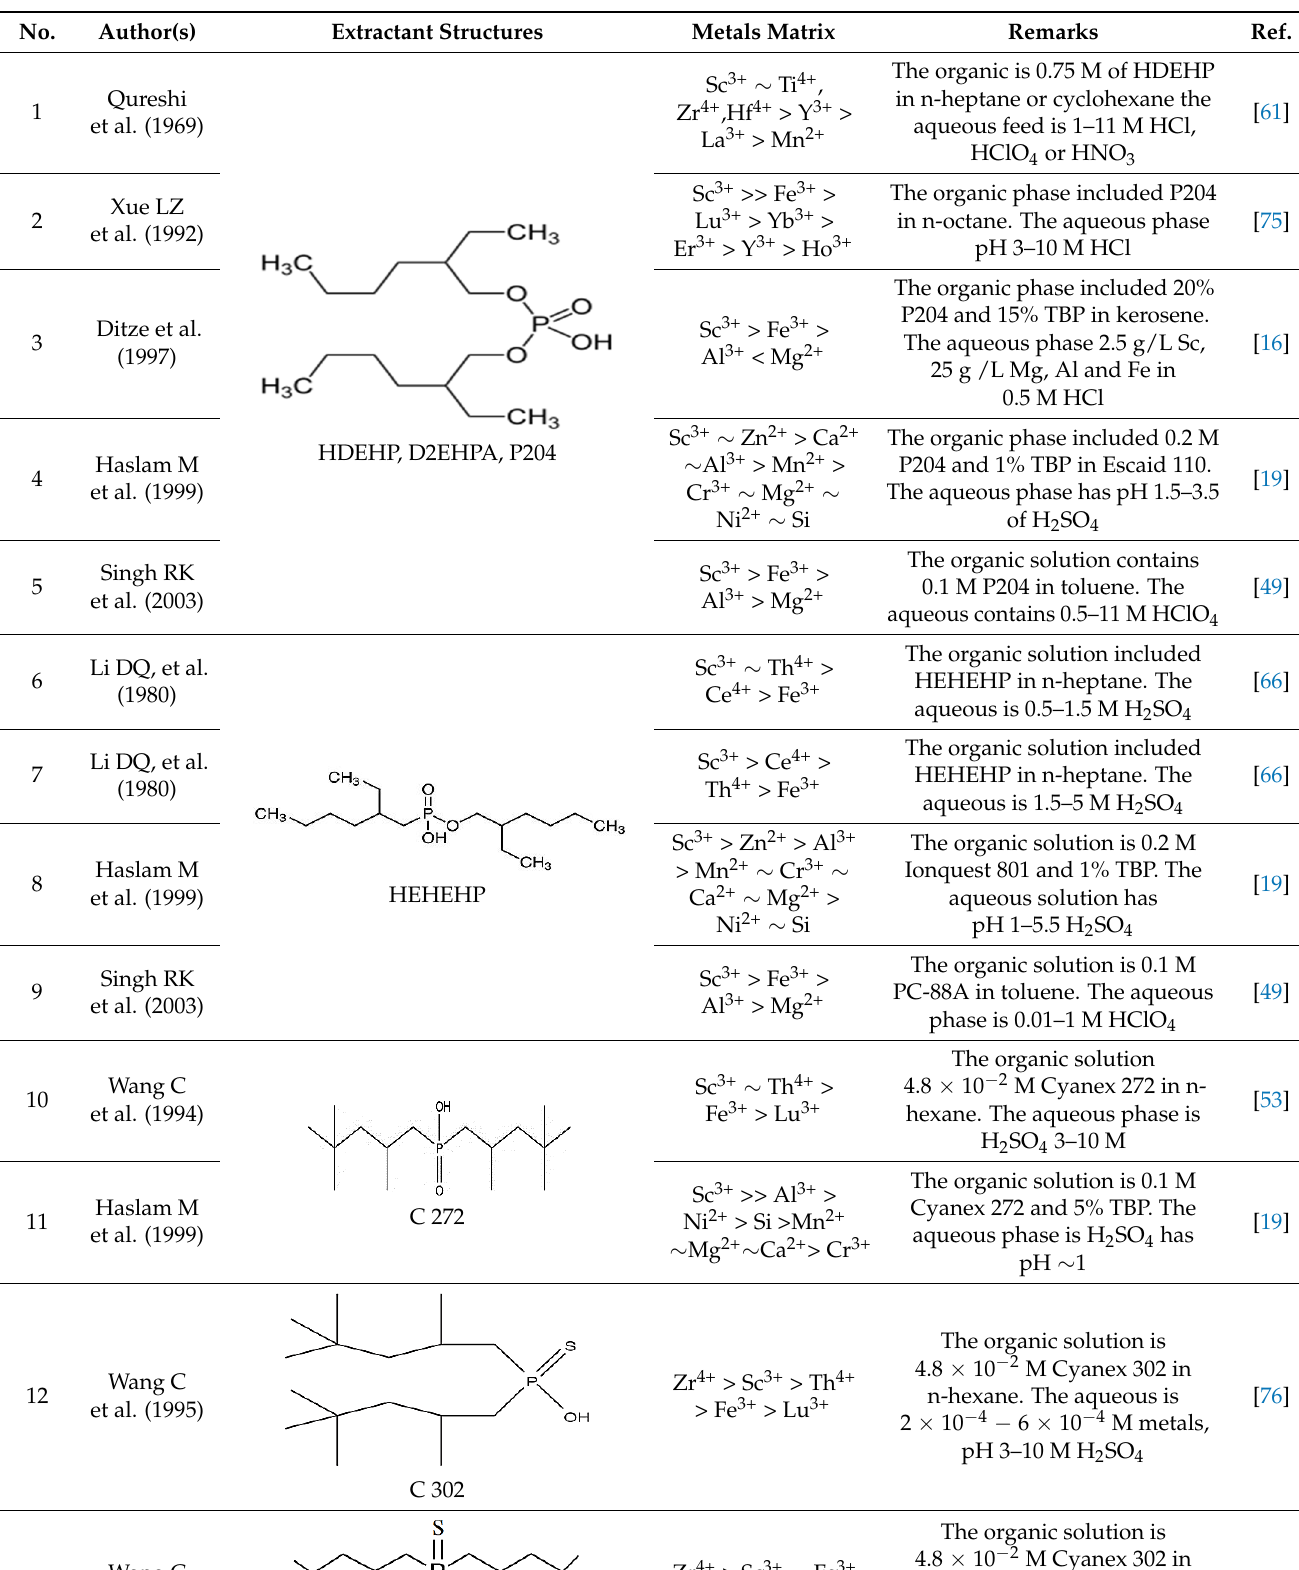
Table 1. Overview of studies on scandium extraction using the SX method.